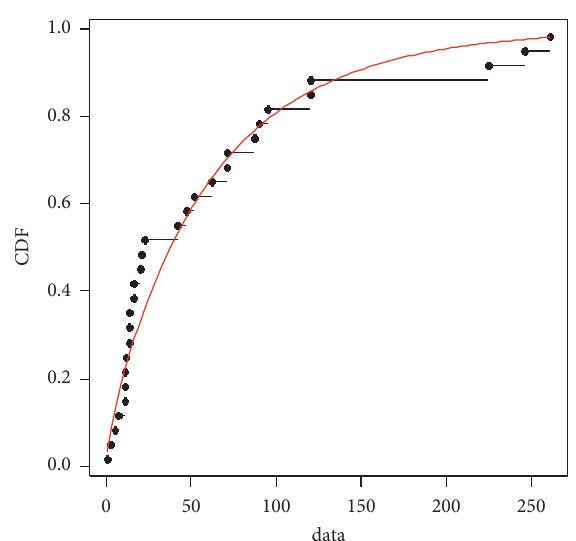
Figure 3: Empirical CDF of the air condition system failure data.